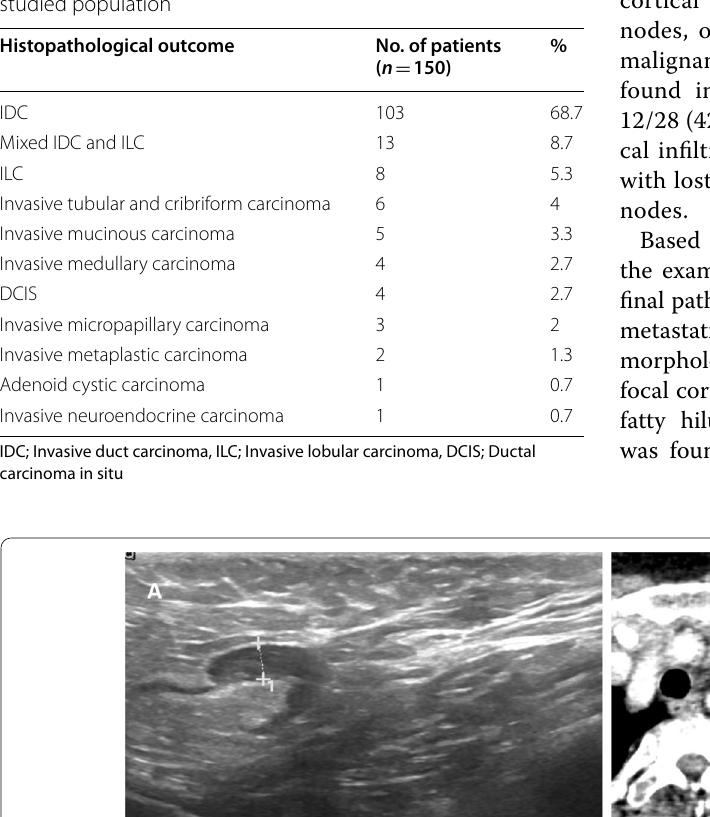
Table 1 Distribution of pathological subtypes among the studied population Histopathological outcome No. of patients